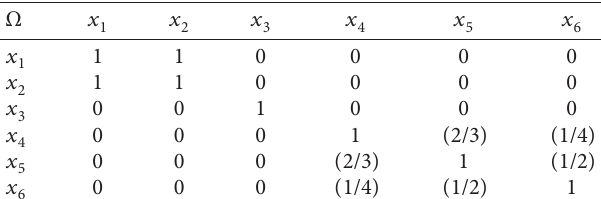
( x ,x ) ∀ i, j ∈ 1 , 2 , ... , 6 { } . i j S